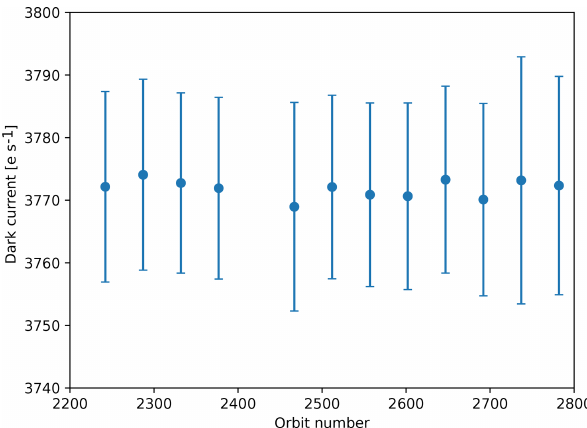
Figure 7. The median dark current and its uncertainty obtained with the FMM closed at the start of the nominal operations phase be- tween orbits 2200 to 2800 (the end of the commissioning phase) as a function of time. The length of time shown is about 6 weeks. Note that due to the structure seen in the dark current, the spread (not shown) is much larger.